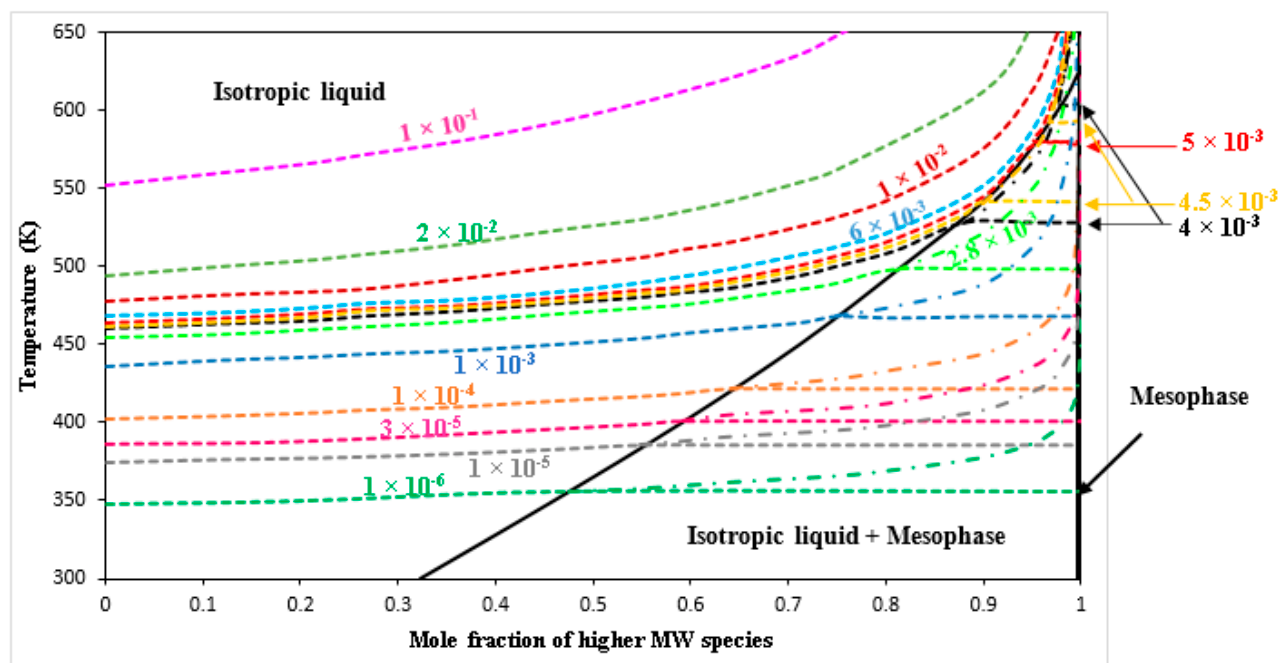
Figure 6. Binary phase diagram of anthracene and a mixture of representative PAHs, which do not contain anthracene, indicating partial pressure of low MW compound. Dashed lines: iso-partial-pressure (bar) of anthracene; dash-dotted lines: metastable iso-partial-pressure (bar) of anthracene.